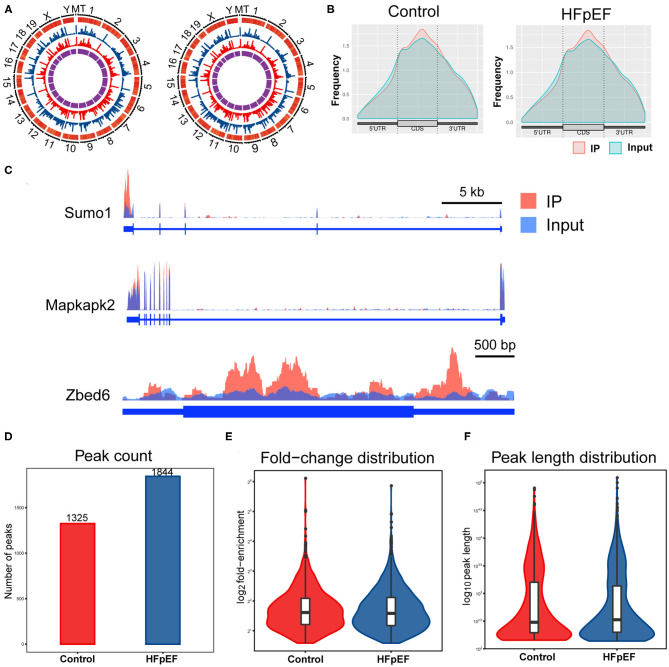
The topological distribution of m6A peaks in HFpEF mice. (A) The distribution patterns of m6A peaks in different chromosomes of control mice and HFpEF mice. (B) The distribution patterns of m6A methylation peaks in gene structures of mRNA. (C) Visualization of representative m6A peaks in the genes of Sumo1, Mapkapk2, and Zbed6, using Integrative Genomics Viewer. The peak of Sumo1 was located at the 3′UTR region, the two peaks of Mapkapk2 were both located at the 3′UTR regions, and the peaks of Zbed6 were located at the CDS and the 5′UTR regions. (D) The number of m6A peaks in the indicated groups. (E) The fold-enrichment of indicated groups. (F) The peak length distribution of indicated groups.